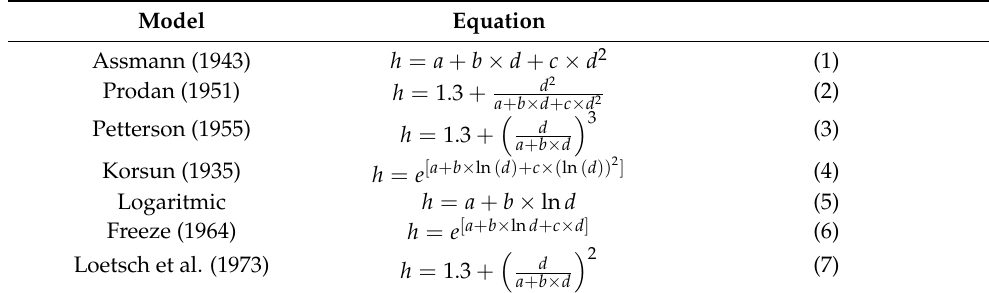
Table 1. Selected height-diameter relationships, where h —height; d —diameter; a , b and c —nonlinear coefficients, as described by Schmidt, Lappi, Peng et al. and Pretzsch (adapted from [24,29,31,32]). Model